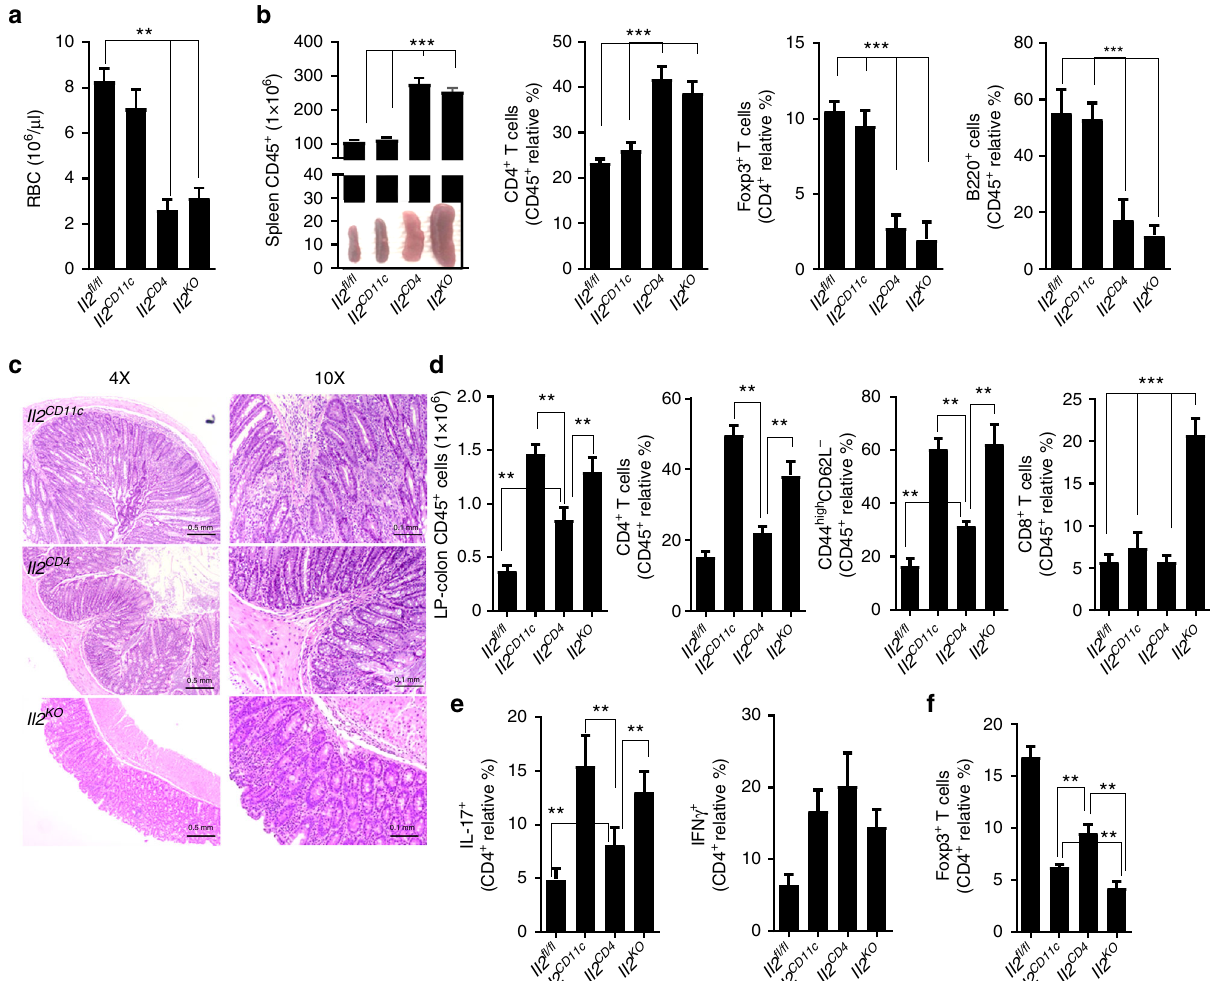
Fig. 9 Systemic and intestinal immune homeostasis in Il2 CD11c and Il2 CD4 mice. a RBC count and b total number of splenocytes and proportion of CD4 + T cells, FoxP3 + Treg cells, and B220 + B cells in spleens of Il2 fl / fl , Il2 CD11c , and Il2 CD4 mice. Representative images of spleens are shown. Data represent